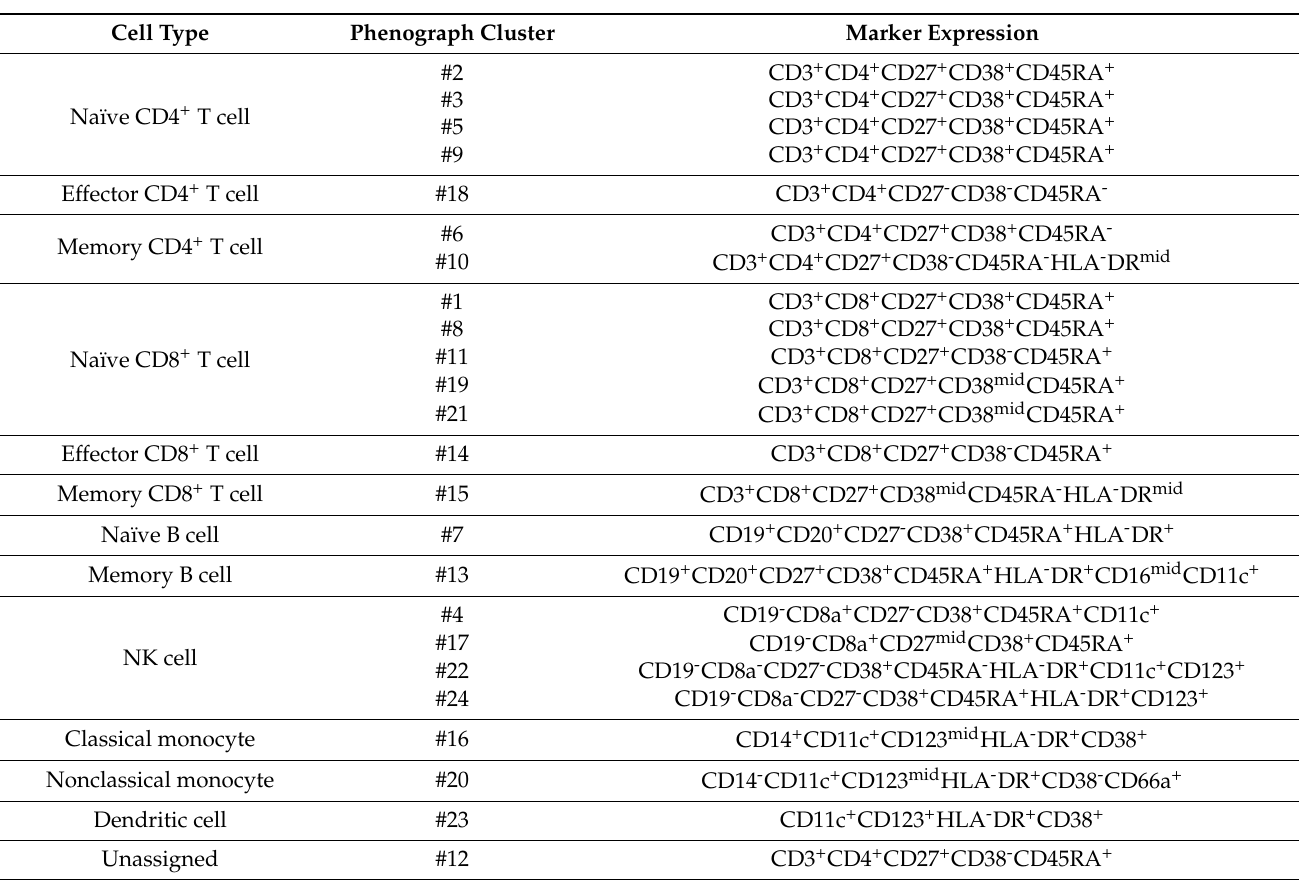
Figure 5. Population abundance of PhenoGraph clusters of immune cells. ( A ) PhenoGraph cluster- overlaid UMAP ( B ) Significant immune-subset cluster population shown in boxplots. Table 1. List of cellular phenotypic surface markers.